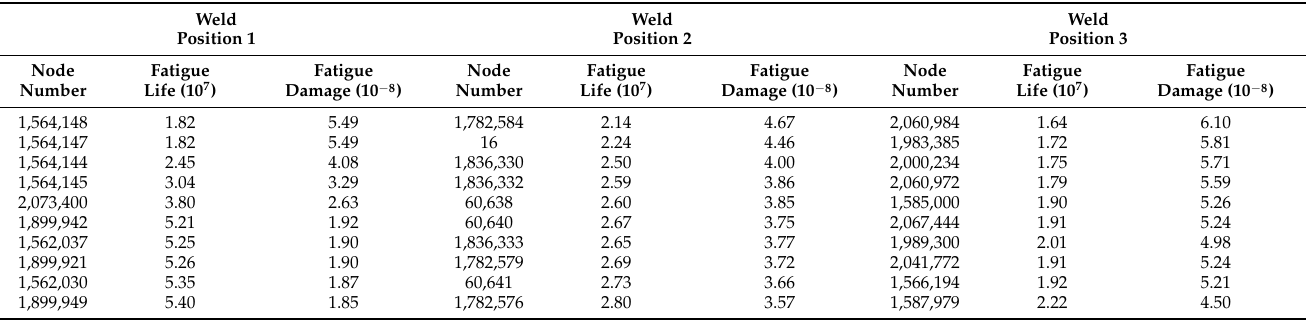
Table 4. Fatigue evaluation assessment results at various weld positions